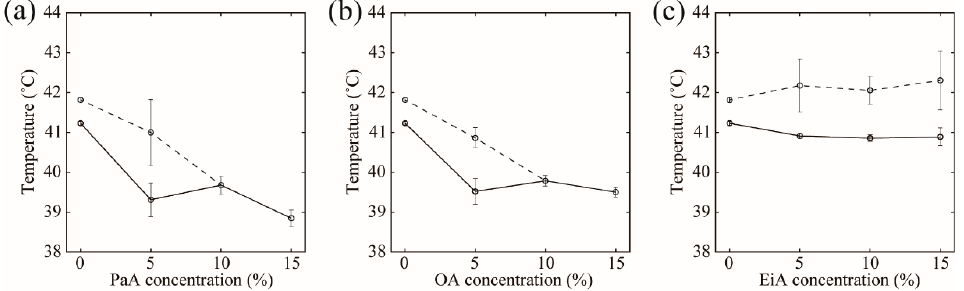
Figure 5. Variation in the peak temperatures obtained from peak deconvolution for ( a ) DPPC/PaA/Chol, ( b ) DPPC/OA/Chol, and ( c ) DPPC/EiA/Chol. MUFA contents of 0%, 5%, 10%, and 15% correspond to DPPC/MUFA/Chol ratios of 90/0/10, 85/5/10, 80/10/10, and 75/15/10, re- spectively. The solid and dashed lines indicate the lower- and higher-temperature peaks, respectively. Because we obtained symmetric thermographs at PaA and OA contents of 10% and 15%, we have simply plotted the peak temperatures from the thermographs in these